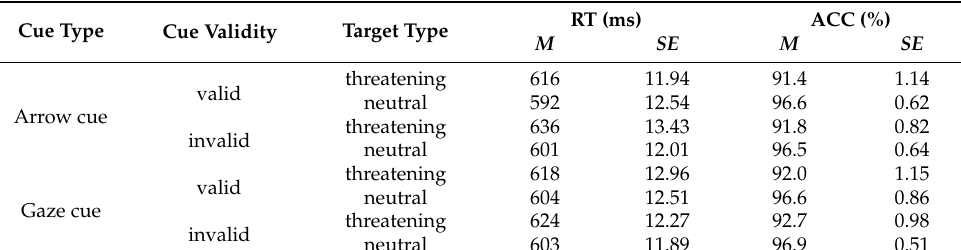
Table 1. Mean RTs and ACC in Experiment 1.